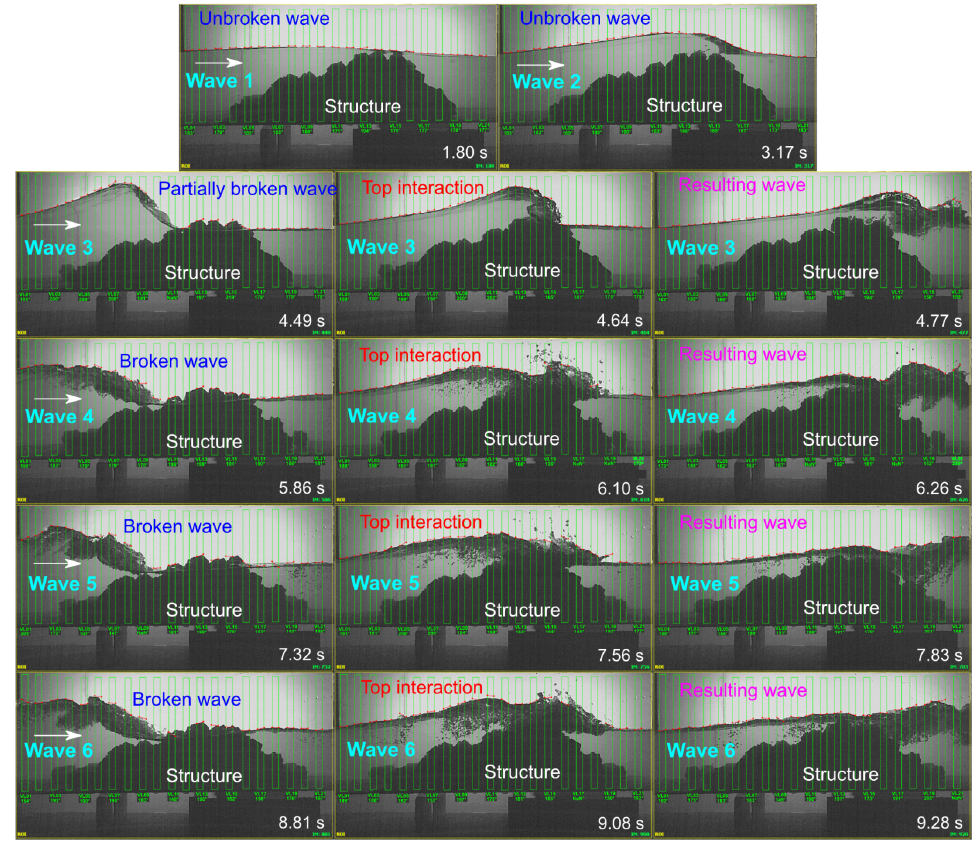
Figure 7. Features of the first six incident waves interacting with the structure. For waves 3 to 6, snapshots of the stages before (left column), during (middle column), and after (right column) the interaction are